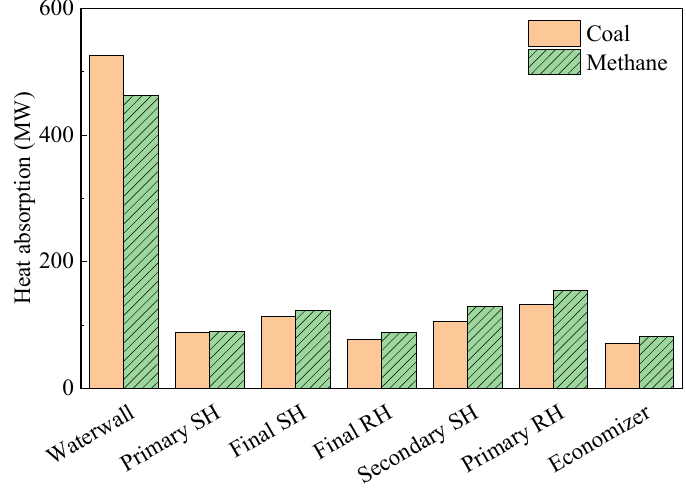
Figure 7. ( a ) Heat flux contours and ( b ) profiles on the data collection line.